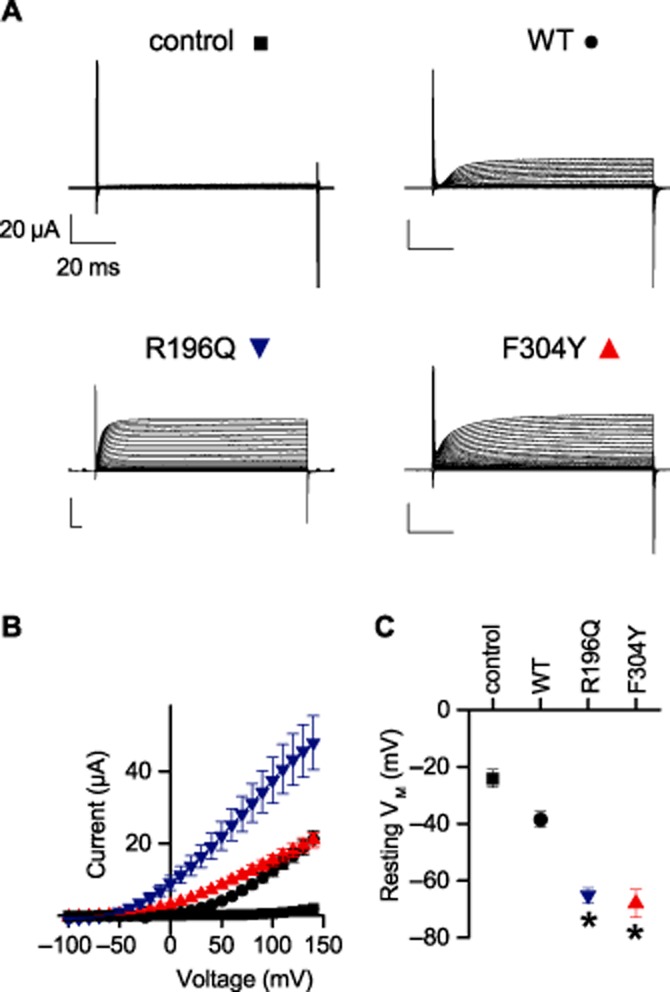
Expression of WT, R196Q and F304Y mSlo3 K+ channels in Xenopus oocytes. (A) Representative current families recorded by two electrode voltage clamp from oocytes injected with different mSlo3 RNA or with no RNA (control) as indicated. Oocytes were held at −80 mV and 100 ms pulses to potentials between −100 and +140 mV were applied. The dashed line represents the zero-current levels and scale bars represent equivalent current amplitudes and timescales. (B) Mean (± SEM) current–voltage relationships of oocytes expressing WT mSlo3 (WT, n = 29), R196Q mSlo3 (n = 8) F304Y mSlo3 (n = 26), and non-injected oocytes (control, n = 12). For symbols used see part (A). (C) Mean (± SEM) resting membrane potential of oocytes in standard Ringer’s solution. *P < 0.0001 compared with control oocytes (Kruskal–Wallis test).